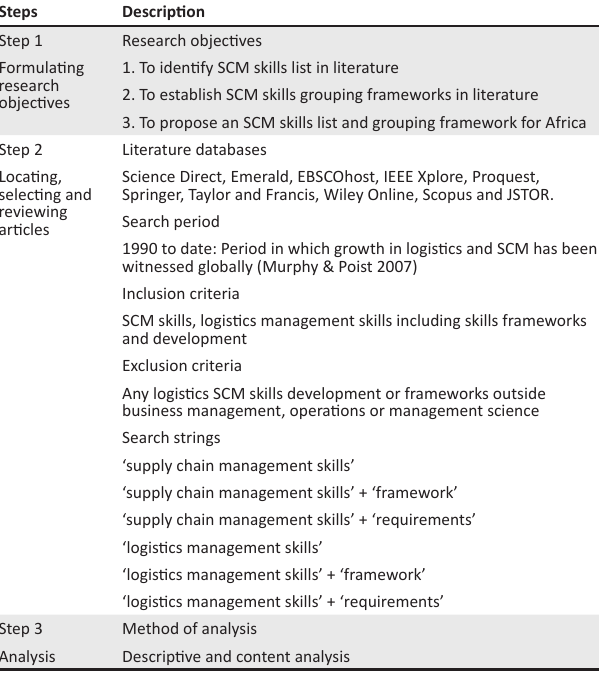
TABLE 2: Research process.